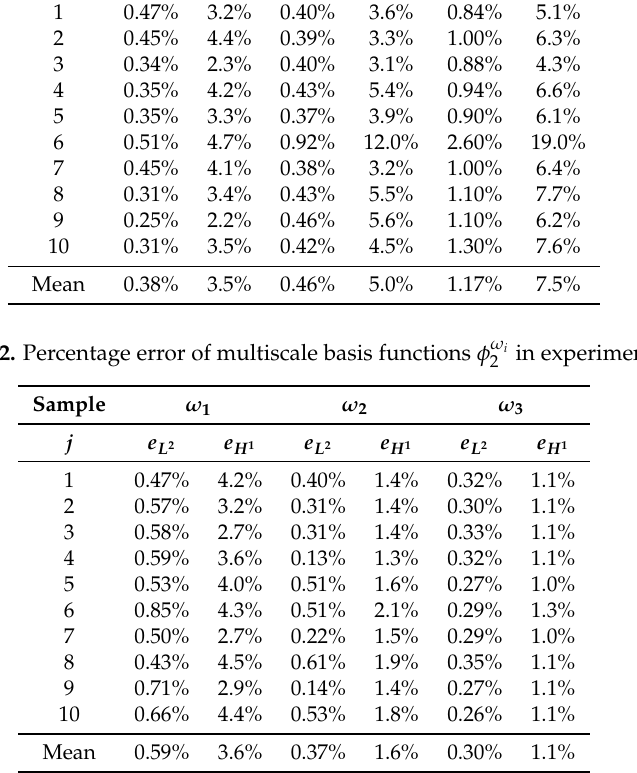
Table 1. Percentage error of multiscale basis functions φ ω i